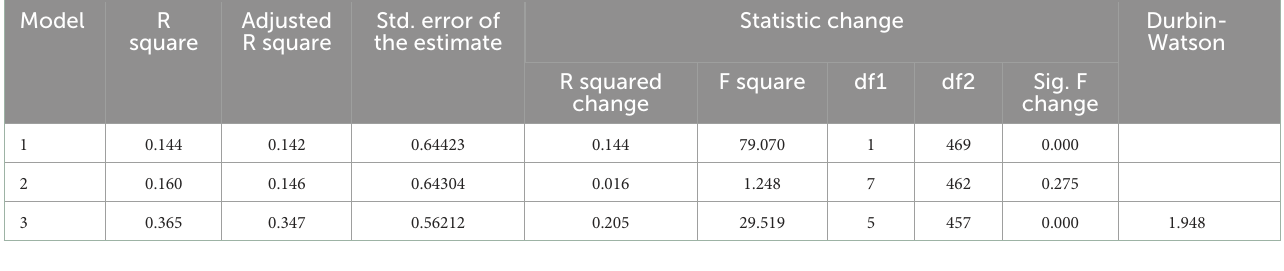
TABLE 5 Factors influencing health satisfaction (Model 1).